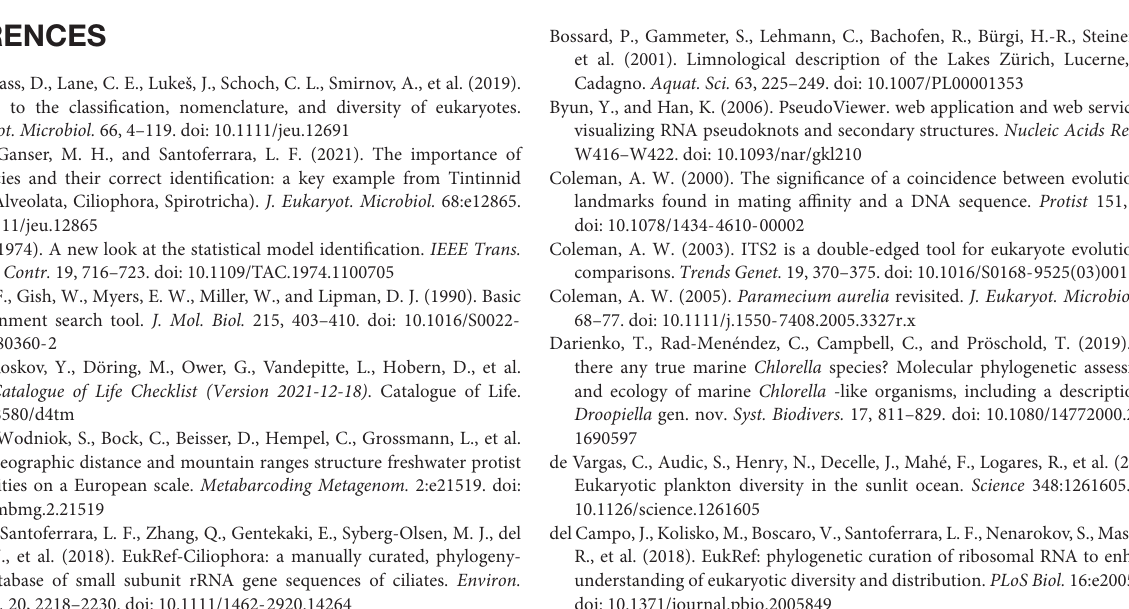
Supplementary Figure 6 | Comparison of temporal and spatial distribution of Urotricha strains in Lake Zurich between sequence data (V9 region) and morphology-based count data. Using the morphology-based approach, U. agilis , U. castalia , and U. pseudofurcata could be identified and counted. From the V9 dataset, only V9 markers from U. agilis , U. castalia _LM, and U. furcata/U. pseudofurcata could be extracted and used for the comparison. Supplementary Figure 7 | Ecological preferences of the investigated ciliate strains. Read abundances were correlated with and plotted against different environmental parameters. The black lines are regression lines and the gray area indicates the 95%-confidence intervals. Correlations were considered significant when the p -Value was < 0.05. Supplementary Table 1 | Valid names of Urotricha species according to Bánki et al. (2021). Doubtful species were excluded (for details, see Foissner and Pfister, 1997). Supplementary Table 2 | Dataset information on the freshwater lakes used to investigate the distribution of Urotricha species under study. Supplementary Table 3 | Occurrence information (presence/absence) of Urotricha species in the investigated lakes. x indicates presence, 0 indicates absence, _V4 indicates when V4 barcode markers were used to screen the dataset. Unless indicated otherwise, only V9 barcode markers were used for the search. Supplementary Table 4 | Main morphometric data on the investigated Urotricha strains. Measurements in µ m. CV = coefficient of variation in %, M = median, IV = in vivo , Max = maximum, Mean = arithmetic mean, Meth = applied methods, Min = minimum, n = number of specimens investigated, P = after protargol staining, QPS = after quantitative protargol staining, SD = standard deviation. Corresponding strains are color-coordinated. Urotricha agilis (CIL-2017/24, CIL-2019/10), Urotricha furcata (CIL-2019/13 and CIL-2019/6), Urotricha pseudofurcata (CIL-2019/3), and Urotricha castalia (CIL-2017/25, CIL-2017/27, and CIL-2019/1; CIL-48 is the original monoculture of U. castalia of which the clonal strain CIL-2019/1 derived). Supplementary Table 5 | Multiple linear regression models of the relationship of U. agilis and U. furcata/U. pseudofurcata abundances to environmental factors. Letter b refers to a regression